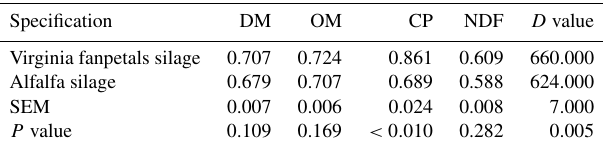
Table 4. Apparent digestibility and D value (gkg − 1 DM) of